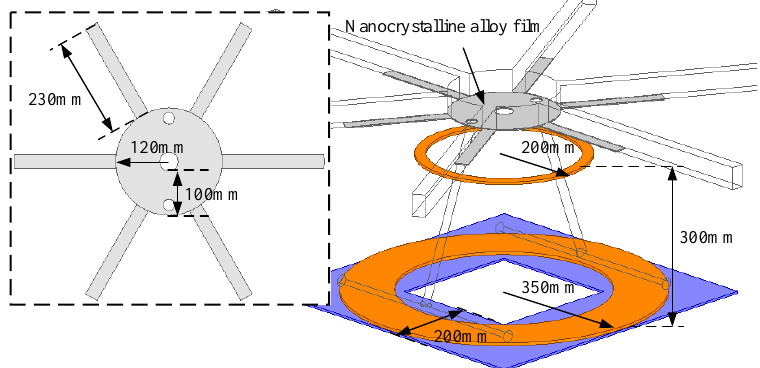
Energies 2022 , 15 , x FOR PEER REVIEW Figure 14. Magnetic circuit model of the proposed magnetic coupler. Figure 14. Magnetic circuit model of the proposed magnetic coupler.